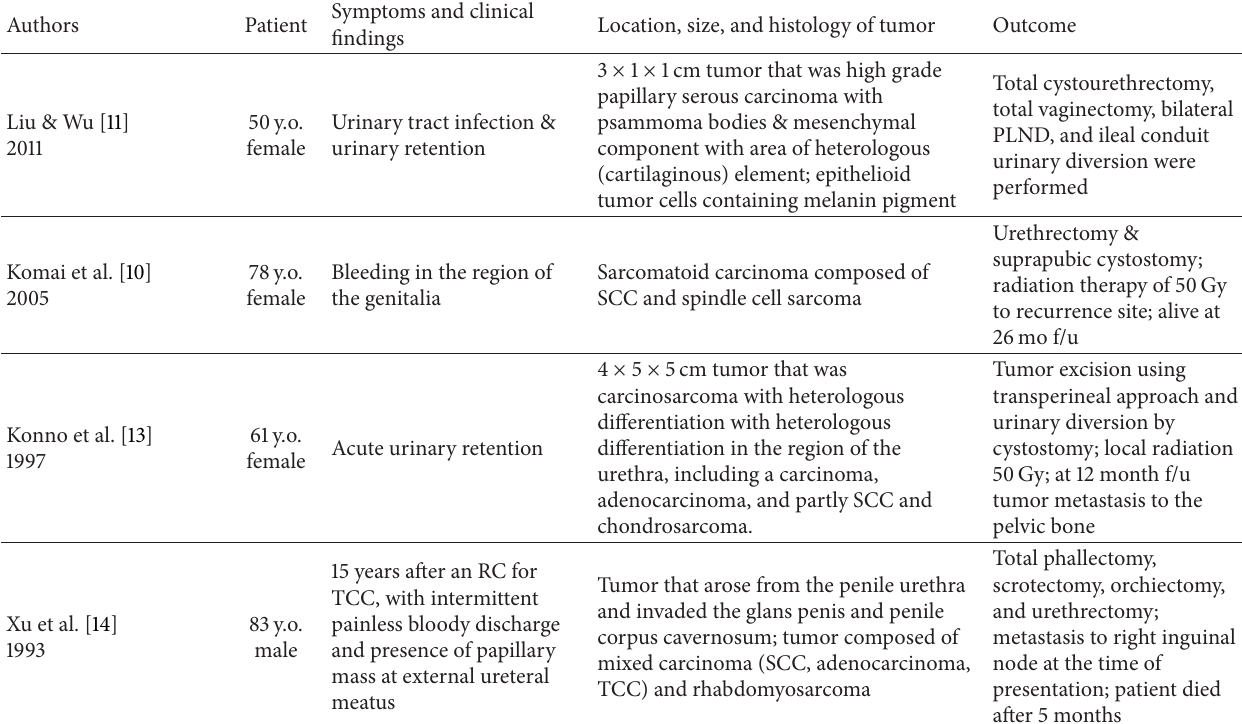
Table 1: Sarcomatoid carcinoma in the